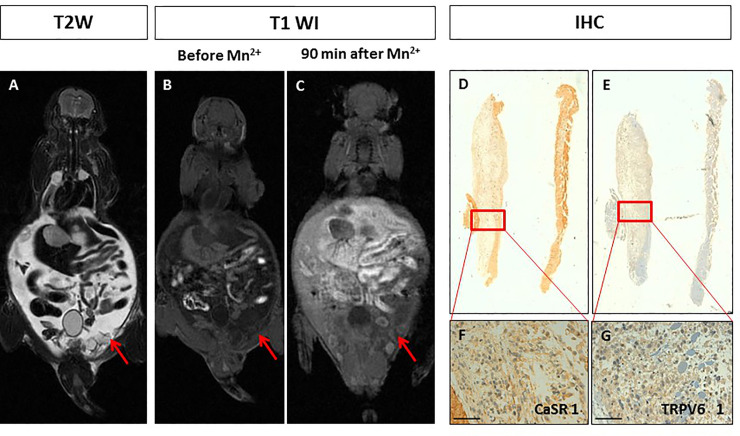
Manganese Enhanced MR Imaging (MEMRI) of pseudo-metastatic prostate cancer animal model and CaSR/TRPV6 receptors levels.A. Multiple peritoneal nodules with diameter of 3 mm (the same mouse of Fig 4). In T2-weighted MR image multiple high intensity peritoneal nodules with ascites are detected. BC. This slice shows the peritoneal nodules in T1-weighted gradient echo images (T1 WI) recorded before and 90 minutes after Mn2+ administration. No manganese uptake is detected (red arrows); D-G. Immunohistochemistry (IHC) of CaSR and TRPV6: A rare positive staining of both receptors was detected in tumour cells (score 1). Scale bar = 100μ.